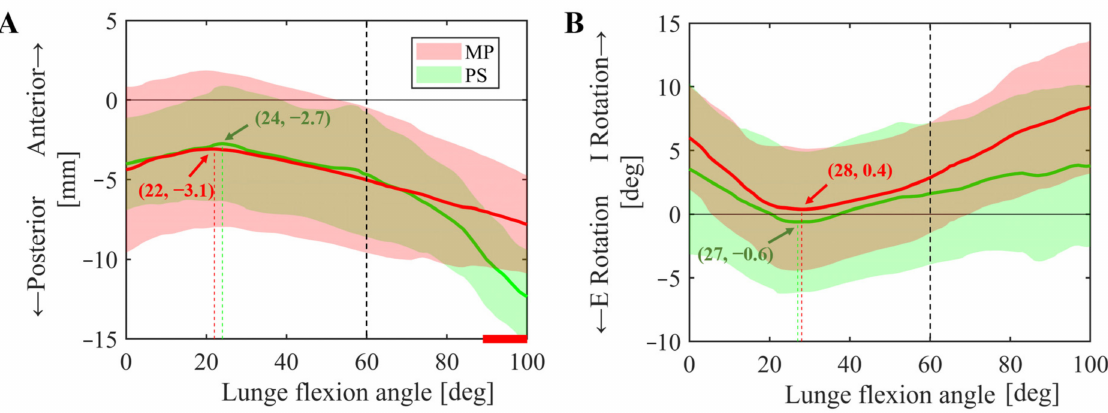
Figure 2. In-vivo kinematics of the MP-TKA and the PS-TKAs during the single-leg lunge. ( A ) The anterior and posterior translations change of the femur relative to the tibia along the flexion angle. ( B ) The internal and external rotation change of the tibia relative to the femur along the flexion angle. The means and standard deviations of anterior+/posterior–translations and internal+/external– rotation (I/E rotation) were represented by solid lines (red line: MP, green line: PS) and shaded area. The red bars along the horizontal axis indicated statistically significant differences between MP-TKA and PS-TKA. MP: Medial-pivot. PS: Posterior-stabilized. TKA: Total knee